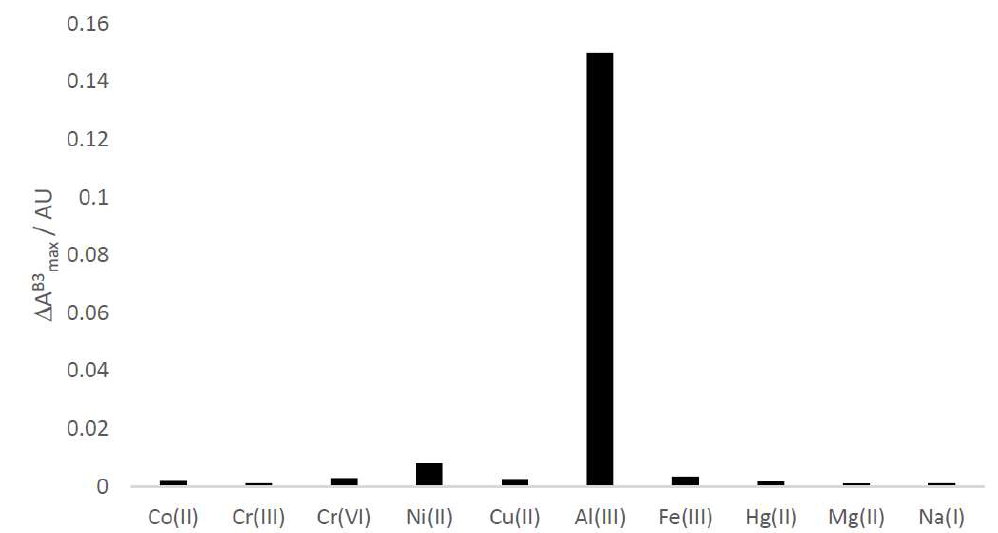
Figure 7. The variation in the maximum absorbance on the interaction band ( A B3 max ) in the presence of different metal ions.